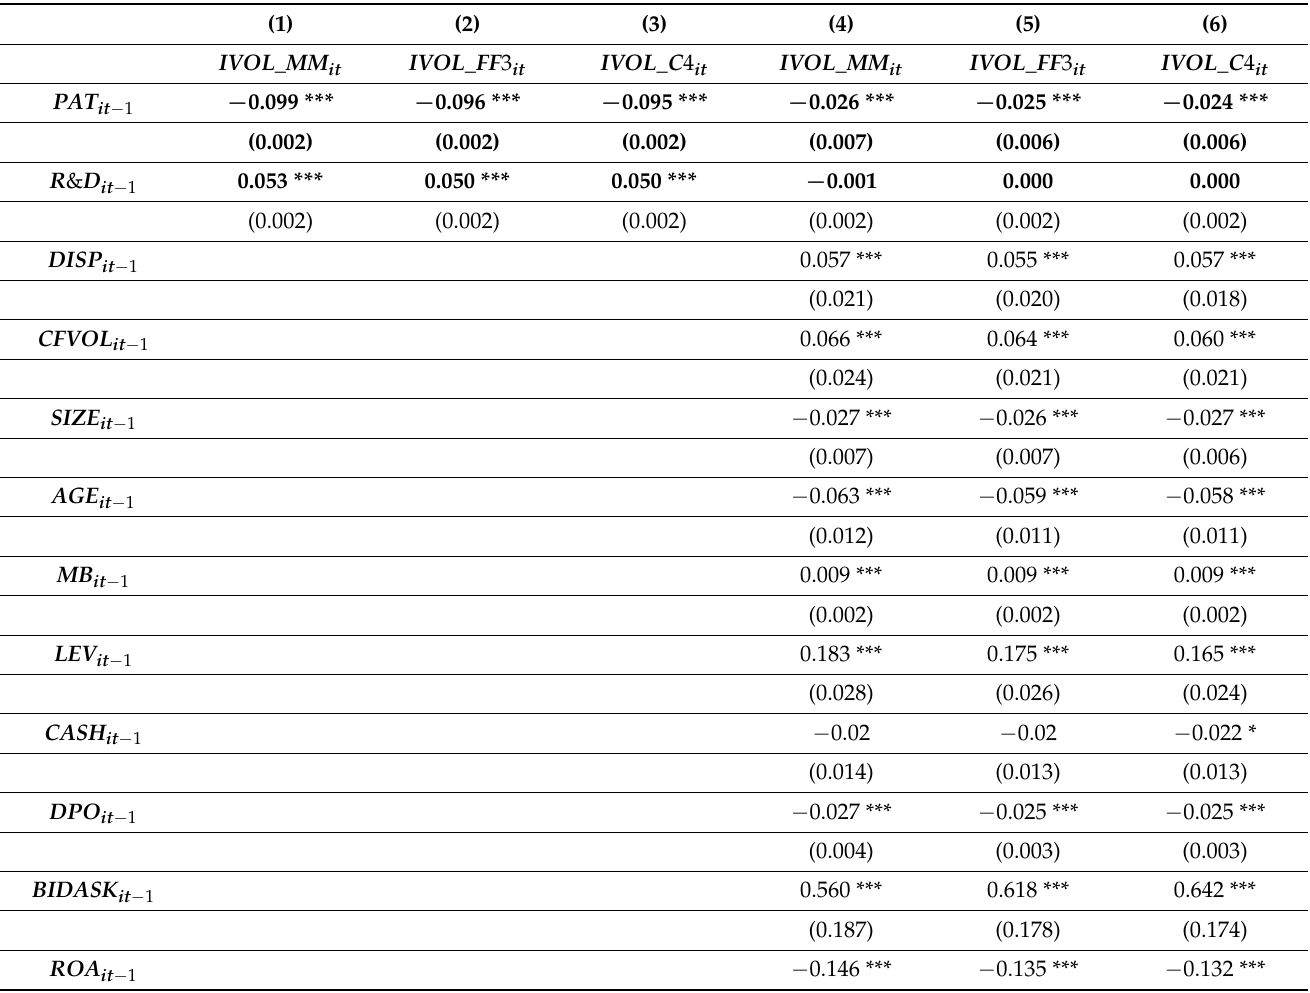
Table 6. Innovation and idiosyncratic volatility. This table shows the relationship between innovation, measured by the natural log of the number of patents weighted by citations (PAT it − 1 ), and different proxies of idiosyncratic volatility ( IVOL _X it ). The definitions of the variables are provided in Appendix A. Fixed effects are included. The standard errors are clustered by firm and year and are reported in parentheses. The sample period is from 1982 to 2015. ***, **, and * denote significance at the 1, 5, and 10% level,